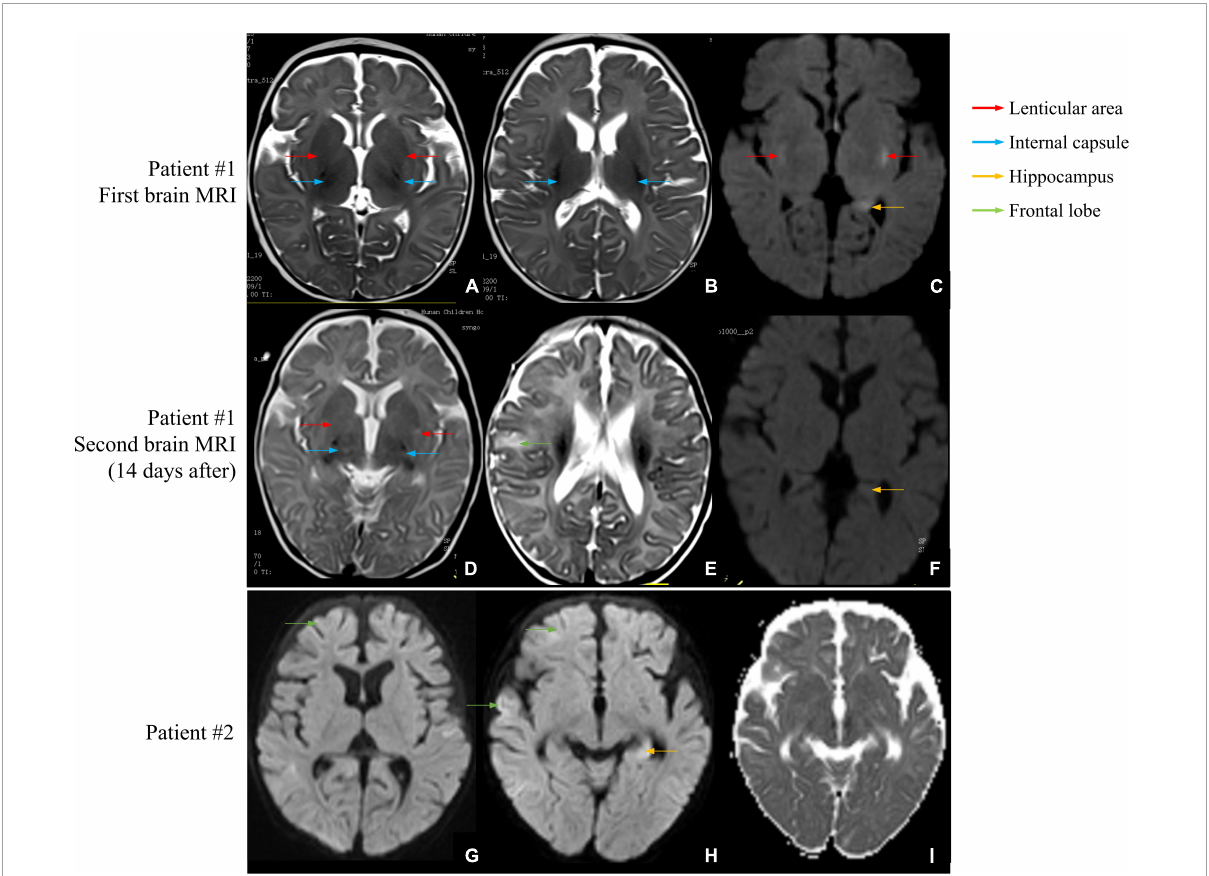
FIGURE1 Brain MRI scans of patients #1 and #2. (A–C) First brain MRI examination of patient #1. (A,B) The T2-weighted image shows a small and slightly long T2 signal shadow in bilateral internal capsules and lenticular nuclei. (C) The diffusion-weighted image shows small patches of a slightly long T2 signal shadow in the upper outer capsule and left hippocampus. (D–F) Second brain MRI examination of patient #1. (D) The T2-weighted image shows a wider T2 signal shadow in bilateral internal and external capsules with higher signal intensity. (E) The T2 signal intensities are higher in the right frontal cortex and subcortical area than in the front. (F) No obvious abnormal signal is found in bilateral hippocampal regions, and no diffusion limitation is found in the lesions. (G–I) Brain MRI examination of patient #2. (G) The diffusion-weighted image shows wider and deeper sulcus fissures in bilateral cerebral hemispheres and slightly higher cortical signal in part of the cerebral hemispheres. (H) Partial cortex of the cerebral hemisphere and the left hippocampus show slightly high signal intensities. (I) The apparent diffusion coefficient map shows a slightly low signal intensity, indicating limited